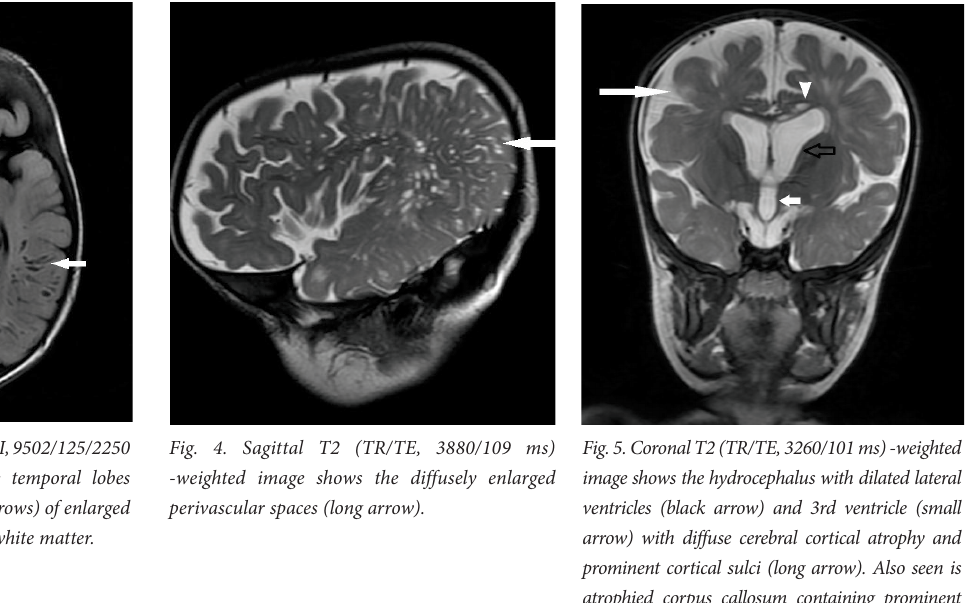
Fig. 4. Sagittal T2 (TR/TE, 3880/109 ms) -weighted image shows the diffusely enlarged perivascular spaces (long arrow).